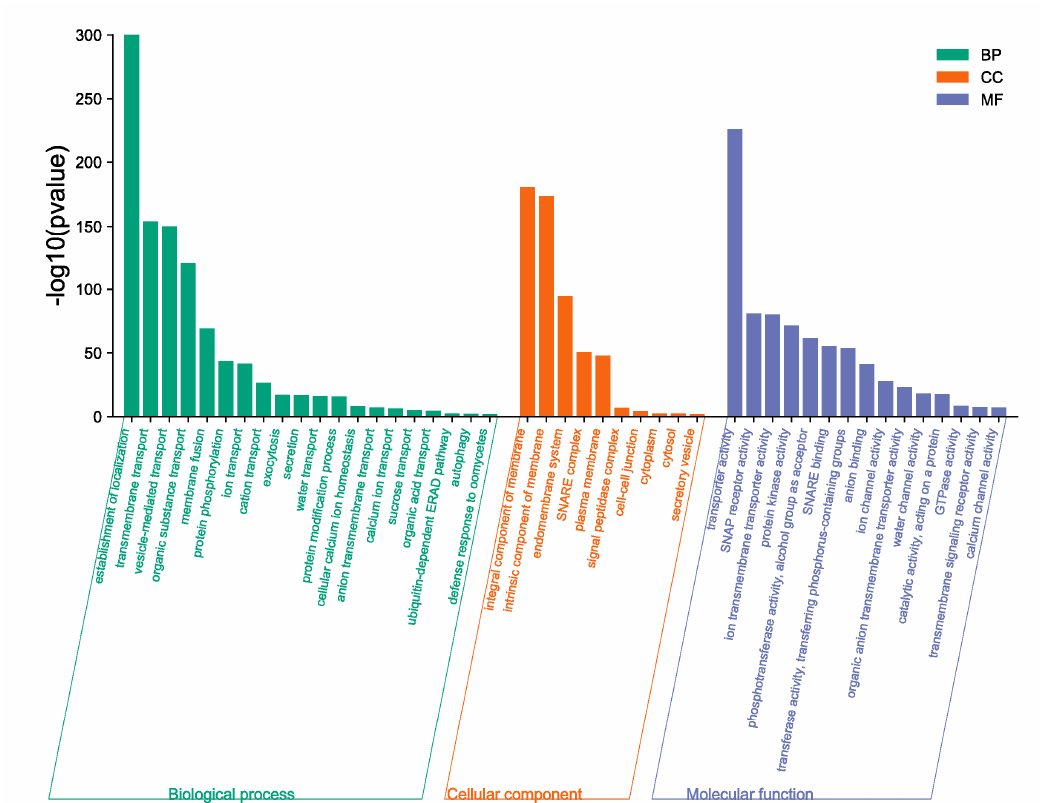
Figure 9. The gene ontology of genes in BnaSNAREs interaction networks.